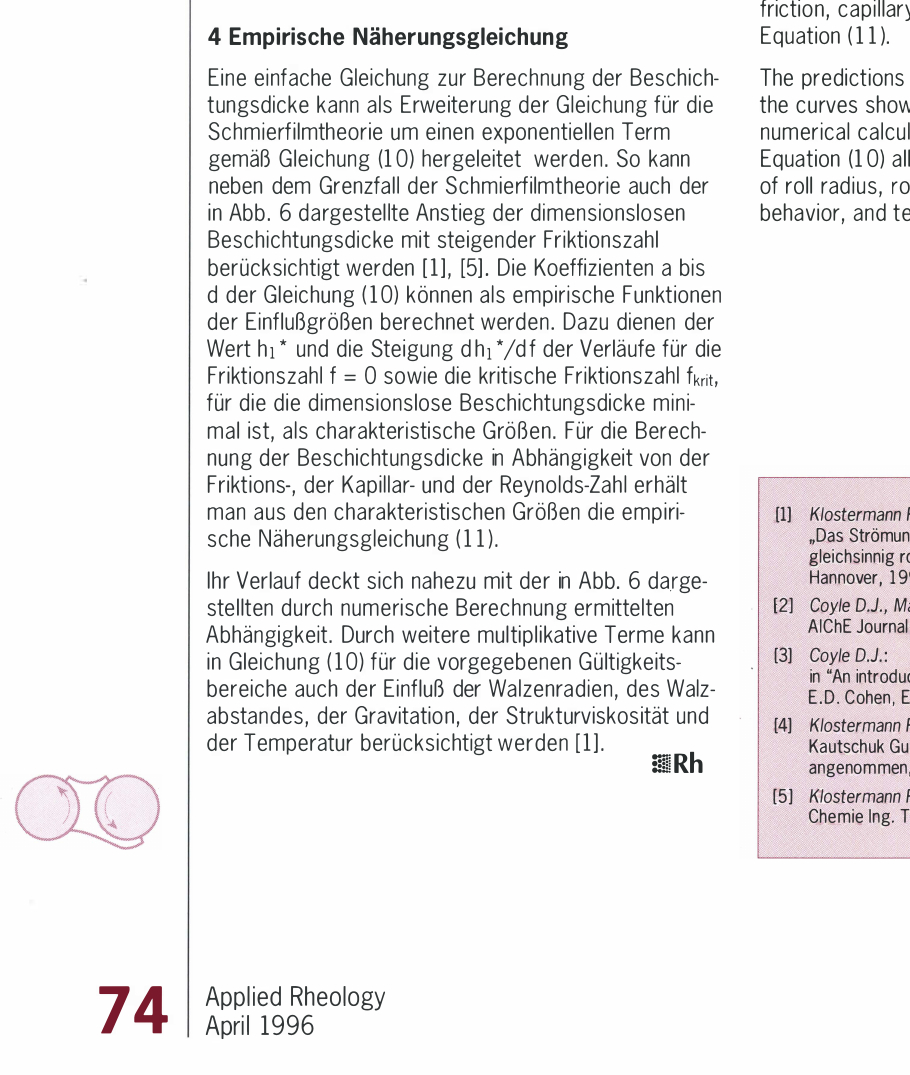
Abb. 8: EinfluB der Lage der Walzen fur unterschied/iche Stokes-Zahlen Fig. 8: The influence of the orientation of the rolls for various Stokes numbers 315 360 Richtung der Gravitation a angle a between the x-axis and the gravitational force Richtung der Gravitationskraft entgegengerichtet, so wirkt die Gravitation auch der Krummung der Profile entgegen, das Profil der Horizontalgeschwindigkeit ist im dargestellten Fall fast linear und der gefarderte der Auftragswalze dagegen in die gleiche Richtung wie die Gravitationskraft, so ist die Krummung der Profile der Horizontalgeschwindigkeit sowie der